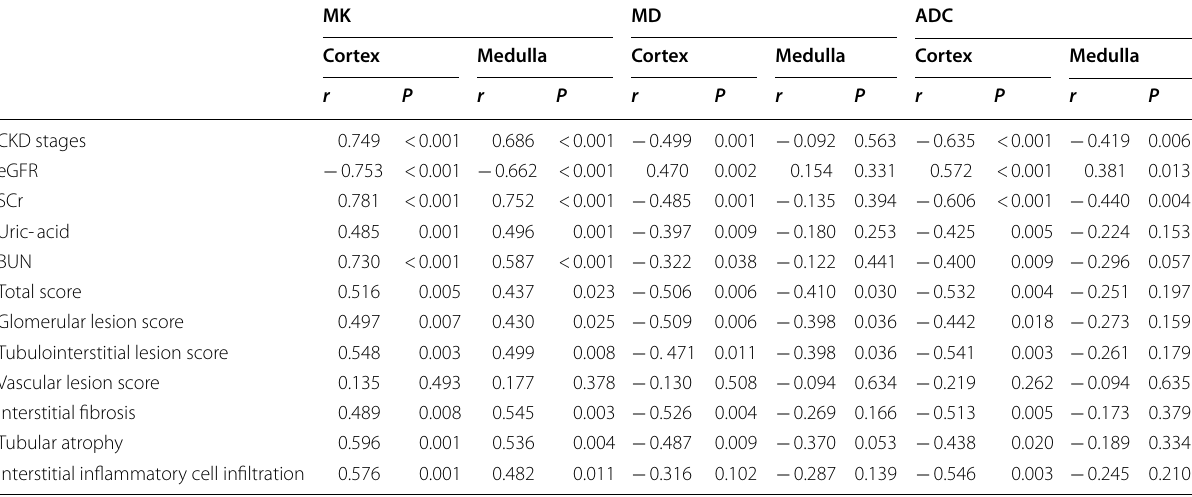
MK, mean kurtosis; MD, mean diffusivity; ADC, apparent diffusion